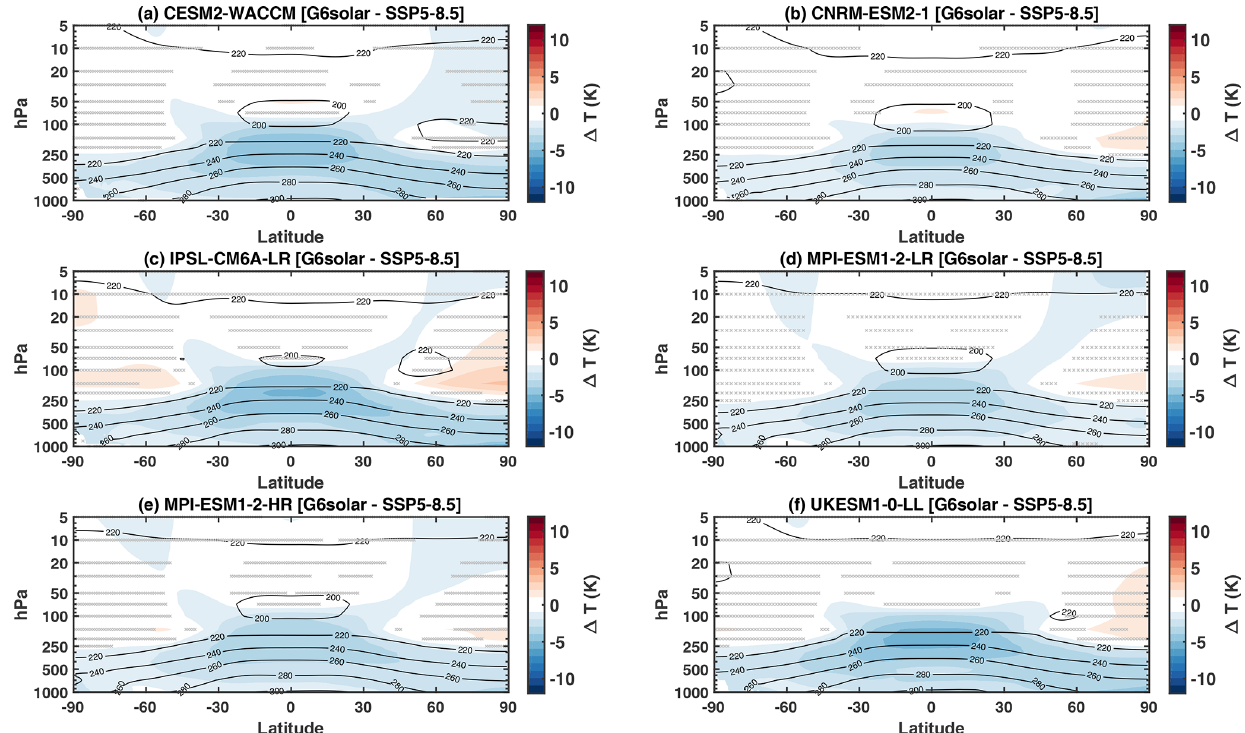
Figure 3. Zonal mean temperature changes (2080–2099) between G6solar and SSP5-8.5 for all GeoMIP models participating in the G6 experiment. Contour lines show the baseline SSP5-8.5 temperature. Gray horizontal lines indicate changes that are not statistically significant over the time period considered when using a double-sided t test at 95% confidence